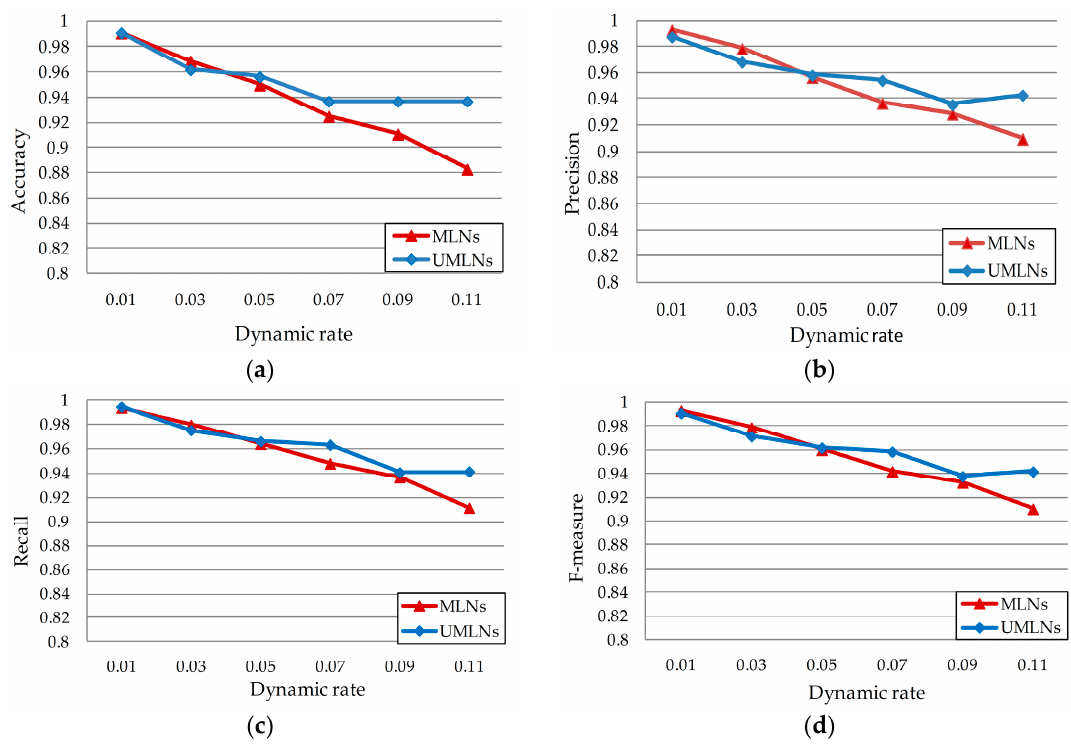
Figure 4. Dynamic event recognition for high frequency events with respect to four scales, ( a ) Accuracy; ( b ) Precision; ( c ) Recall; ( d ) F-measure.